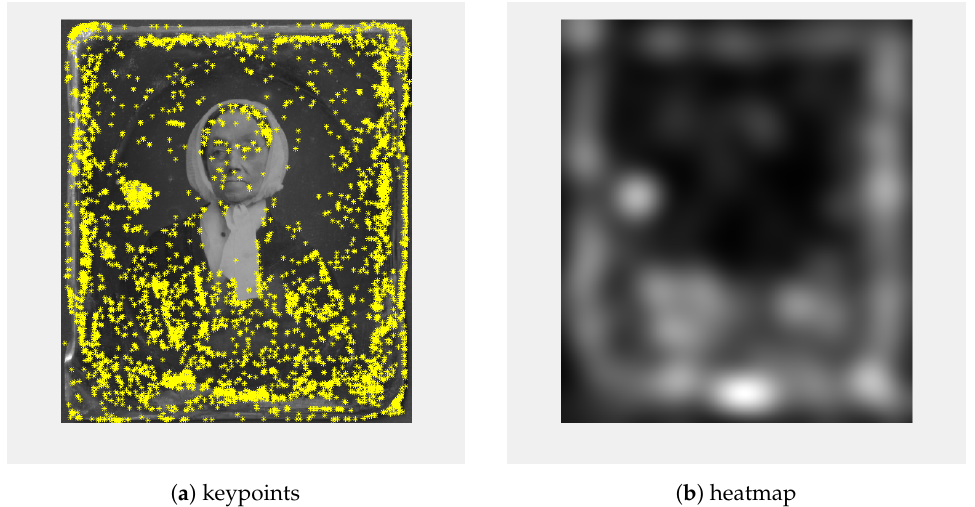
Figure 6. Keypoints ( a ) calculated using Co-SIFT detector, heatmap ( b ) calculated from the Co- SIFT